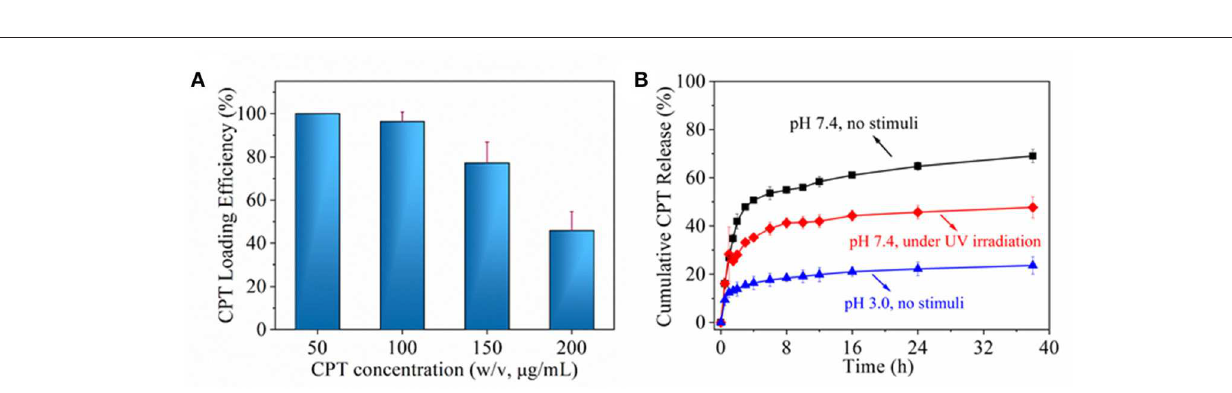
Frontiers in Chemistry |